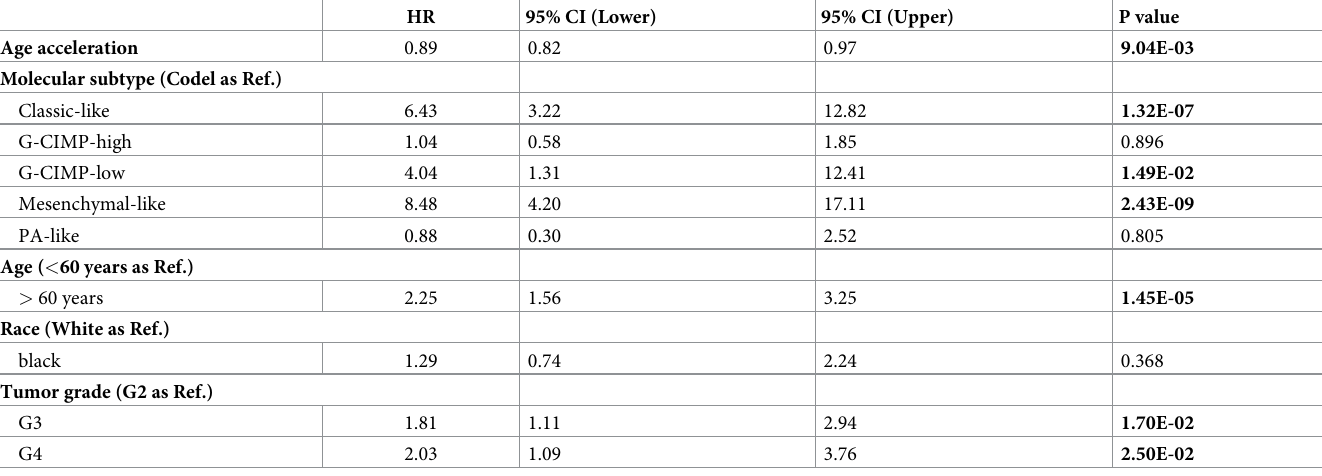
Table 4. Overall survival of gliomas patients in multivariate analysis.